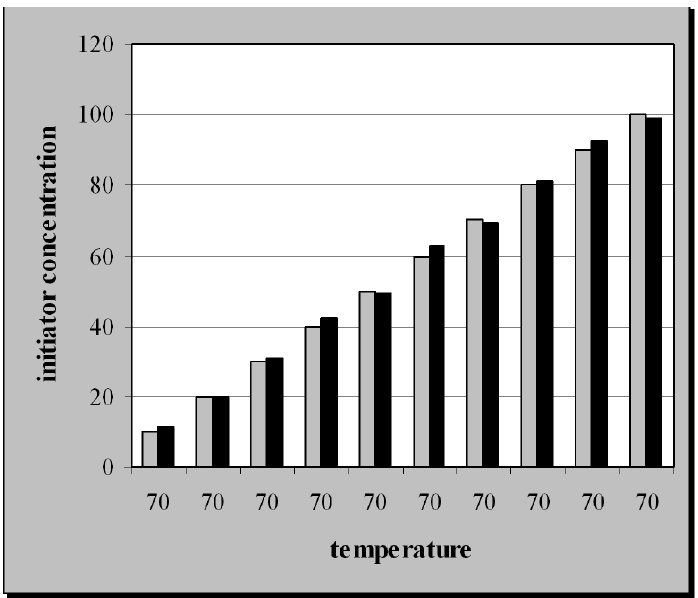
Fig. 22 Initial initiator concentrations obtained with MLP (2:12:4:2) in INN modeling at T = 70 o C ; gray bars - simulation training data; black bars - results of the inverse neural